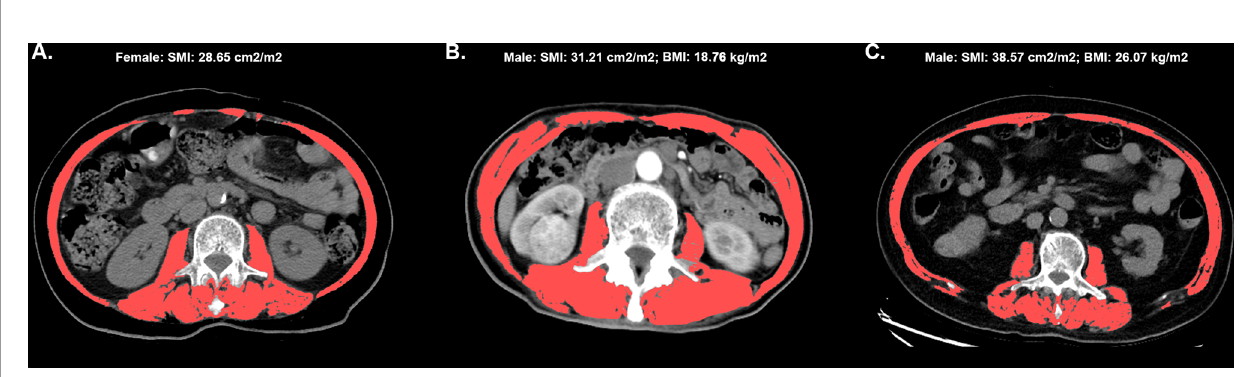
FIGURE 1 | The cross-sectional image of the third lumbar vertebra, and the skeletal muscle is highlighted in red. The labels (A – C) represents three different patient images, (A) The image of female patient with SMI 28.65 cm 2 /m 2 ; (B) The image of male patient with SMI 31.21 cm 2 /m 2 and BMI 18.76 kg/m 2 ; (C) The image of male patient with SMI 38.57cm 2 /m 2 and BMI 26.07 kg/m 2